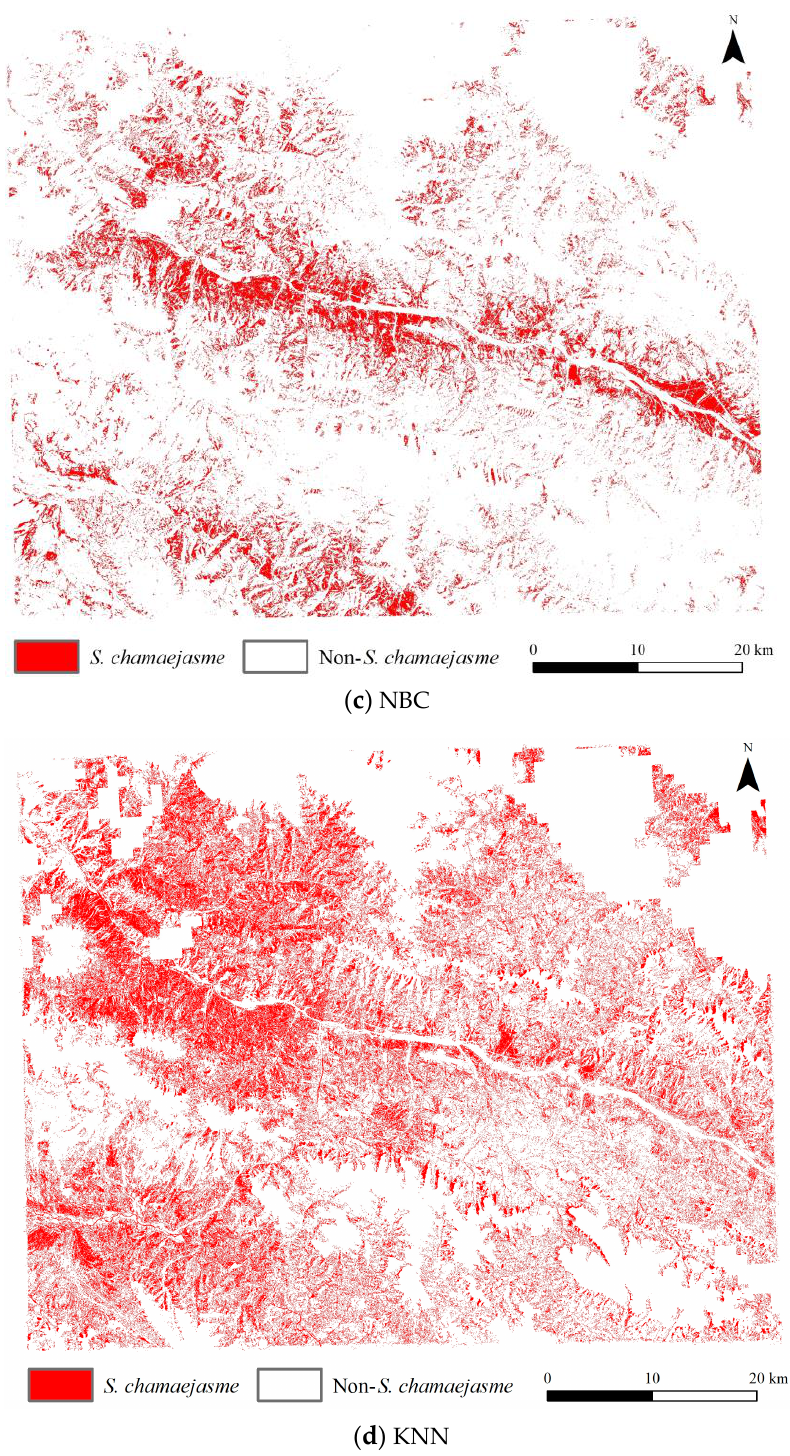
Figure 7. Distribution map of S. chamaejasme based on the four algorithms.